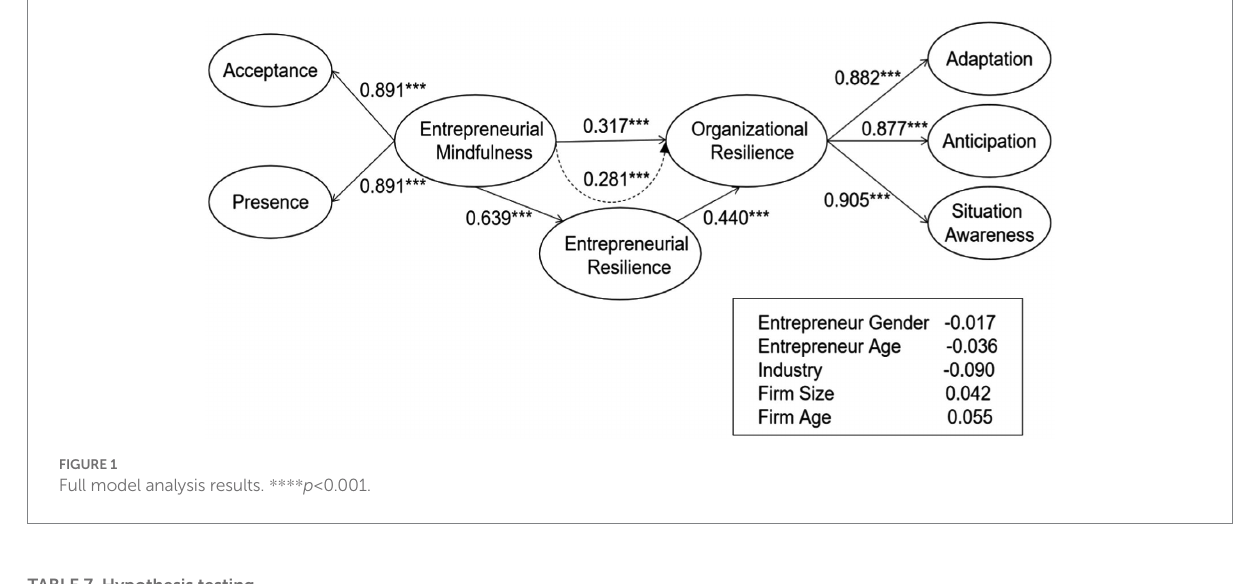
TABLE 7 Hypothesis